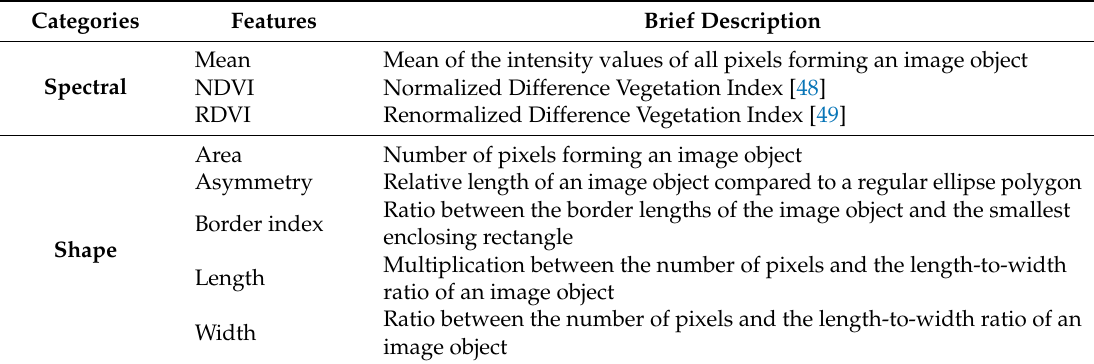
Table 1. Object-based features derived from